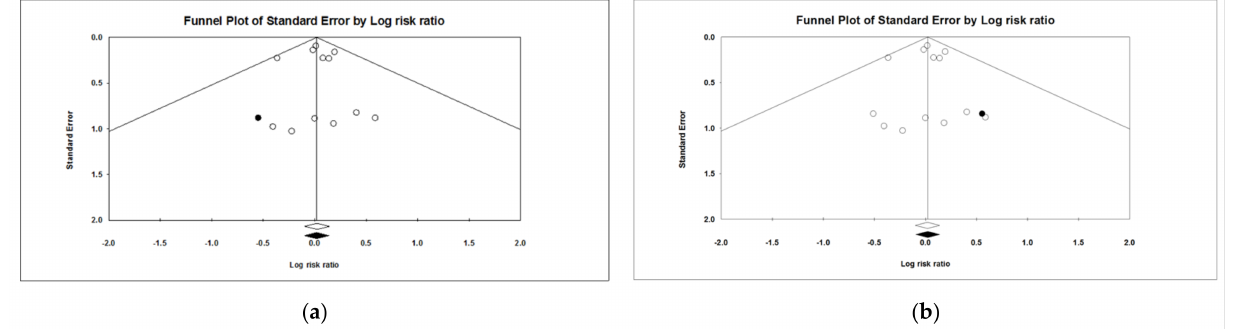
Figure 1. Funnel plot for assessing publication/selection bias, displaying the log risk ratio of overall mortality (from allocation to end of finisher) between Fostera ® Gold PCV MH and comparator (x-axis) by standard error (y-axis). The vertical line represents the overall effect size estimate. Without bias, the number of studies at both sides of the vertical line is expected to be equal. The “trim and fill” funnel plots display the observed (open circles) and the imputed study (filled circle), as well as the observed (open diamond) and imputed point estimate (filled diamond). ( a ): Funnel plot for US field studies only. ( b ) Funnel plot for all studies (US field studies and Korean